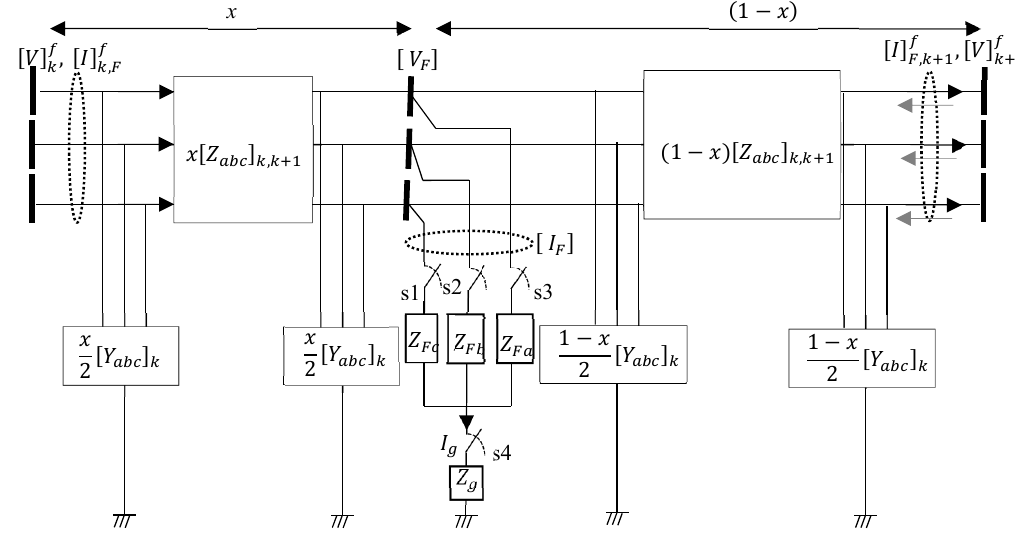
Figure 2. Distribution line model for different types of fault.